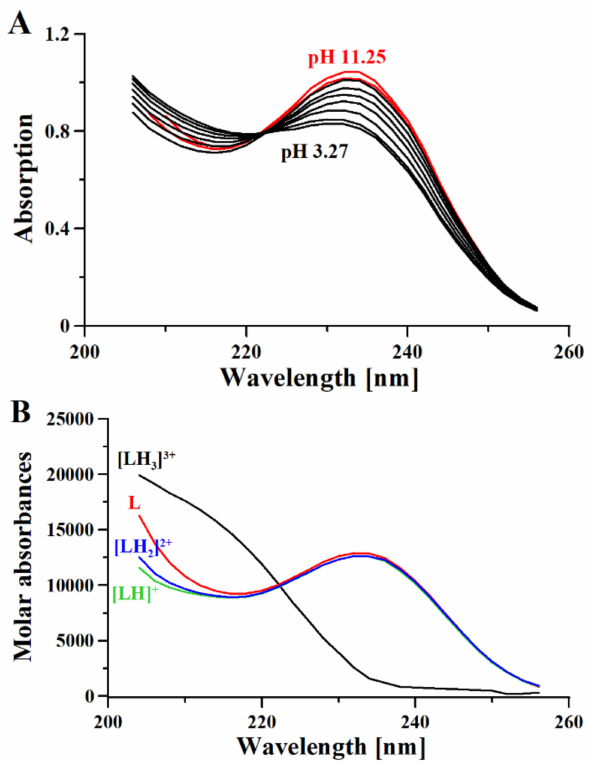
Figure 3. UV spectra ( A ) and Molar absorptivity spectra ( B ) of metformin (L) calculated with